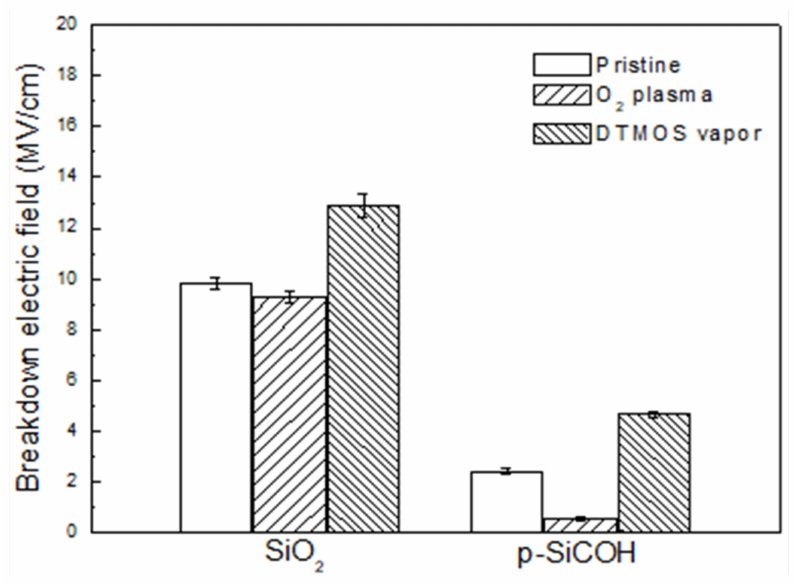
Figure 6. Breakdown fields of SiO 2 and p-SiOCH after O 2 plasma and DTMOS vapor treatments.